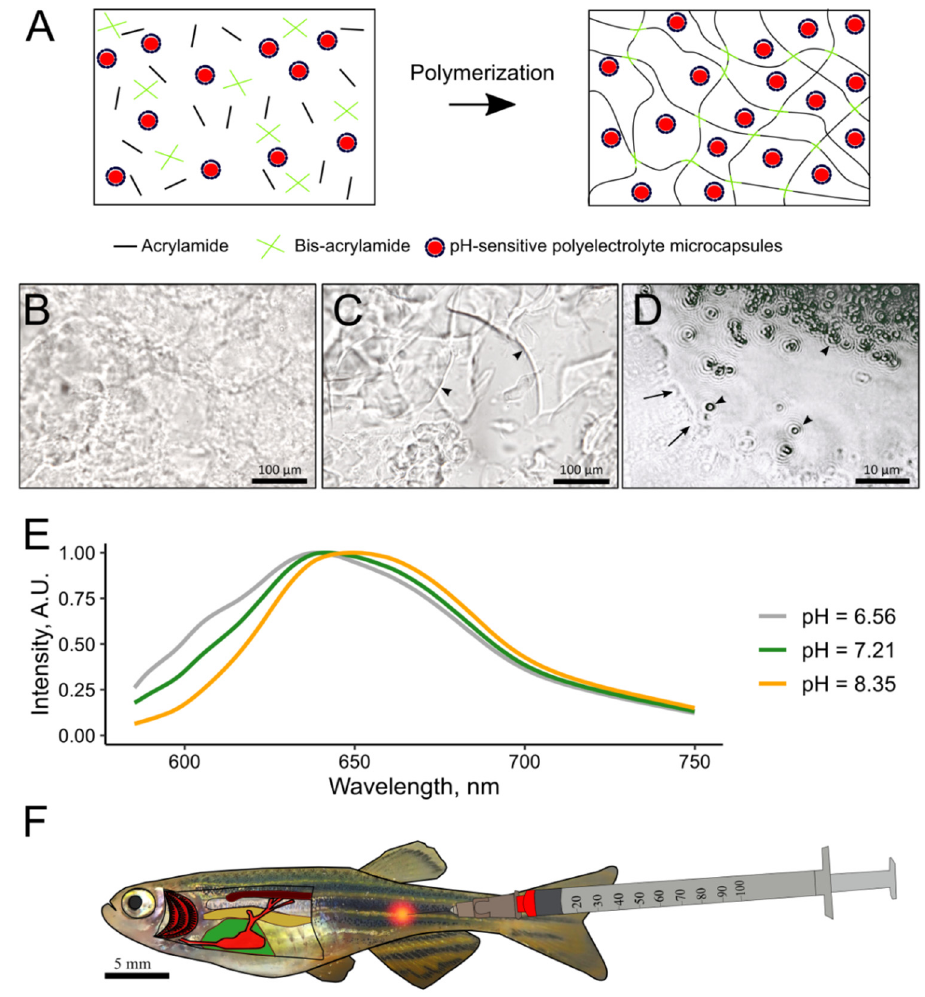
Figure 1. Preparation and use of PAAH + PMs with pH-sensitive SNARF-1. ( A ) a scheme of polymerization of PAAH with embedded PMs. ( B ) representative image of 2.7% PAAH crushed with a cover glass. ( C ) representative image of 3.3% PAAH crushed by a cover glass. Arrowheads indicate chips in the squeezed gel. ( D ) 2.7% PAAH with fluorescent PMs smeared on glass. Black arrows indicate the border of the gel. The arrowheads point to the microcapsules. ( E ) example fluorescence spectra of a PAAH + PMs with microencapsulated SNARF-1 at different pH, obtained using the red channel of a fluorescent microscope and normalized at peak intensity. ( F ) general plan of the fish body with the red dot marking the site of the PAAH + PMs injection.